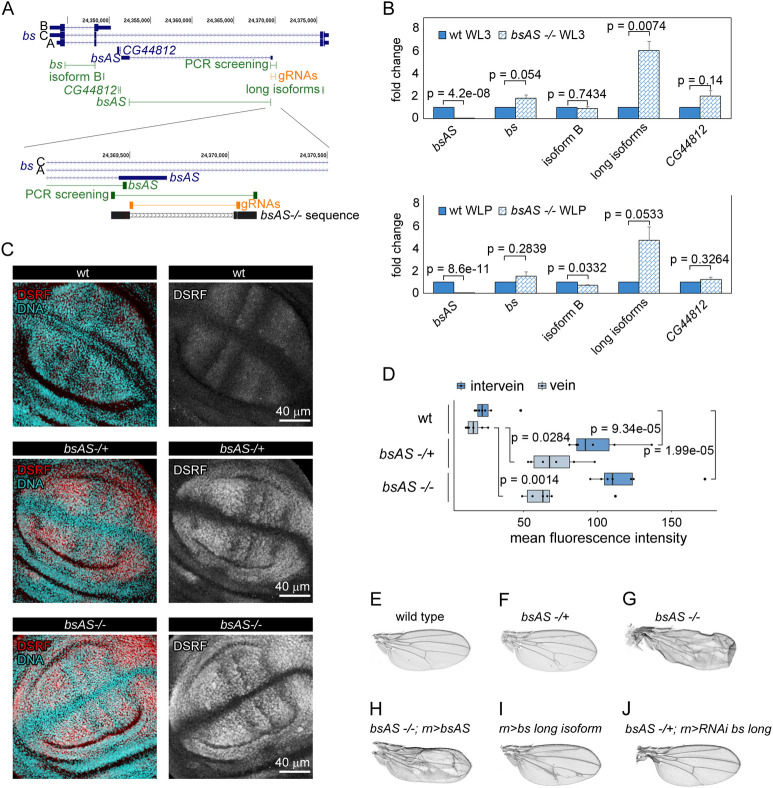
bsAS controls bs isoform usage during fly development.(A) Distribution of primers and CRISPR gRNAs along the bs locus. Upper panel, primers amplifying the different isoforms of bs and bsAS are depicted in green; gRNAs used to induce the deletion of bsAS are depicted in orange. Lower panel, zoom of the lncRNA TSS region. Sanger sequence of bsAS mutant flies is depicted in black. A 560 bp long deletion was induced around the TSS of bsAS. A small deletion of 2 nucleotides at the 5’ region of the TSS is also observed. (B) Relative expression of bs and bsAS in bsAS -/- and wt L3 (upper panel) and LP (lower panel) wings. The lncRNA is not expressed in bsAS -/- wings. The overall expression of the bs gene seems to be slightly higher in mutant than in wt wings, especially in L3 stage; however, when comparing the expression of bs isoforms, we do not observe differences in the expression of the short one between the mutant and the wt, while the long isoforms are overexpressed up to 6-fold in the mutants. Error bars depict Standard Error of the Mean (SEM) of at least three biological replicates. Statistical significance was computed by one-sample t-test. (C) Expression pattern of DSRF in bsAS mutant wing imaginal discs. Immunostaining of DSRF (red and grey) in wt (upper panels), bsAS -/+ (middle panels) and bsAS -/- (lower panels) WL3. Nuclei, stained with DAPI, are depicted in blue in all cases. (D) Quantification of DSRF staining in vein and intervein regions of wt and bsAS mutant wing imaginal discs. Both vein and intervein regions exhibit a significant increase of DSRF staining in bsAS mutants compare to wt wings. Statistical significance was computed by two-sample t-test. (E-J) Adult wings from males. (E) Wild type. (F)
bsAS heterozygous mutant. The wings present extra veins invading intervein tissue. (G)
bsAS homozygous mutant. The wings are creased and vein pattern is completely impaired. (H)
bsAS homozygous mutant overexpressing transgenic bsAS under the control of rotund (rn) driver. The mutant phenotype is not rescued by the overexpression of the lncRNA. (I) Wings overexpressing bs isoform A under the control of the rn driver. Extra veins appear within intervein tissue, resembling the phenotype of bsAS heterozygous mutants. (J)
bsAS heterozygous mutant wings overexpressing the RNAi against bs long isoform. The overexpression of the RNAi rescues the extra vein phenotype in bsAS heterozygous mutant background.